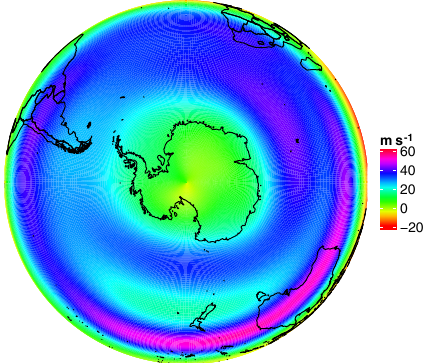
Figure 1. Climatological zonal wind (ms − 1 ) in 200hPa in austral winter (JAS) averaged for the period